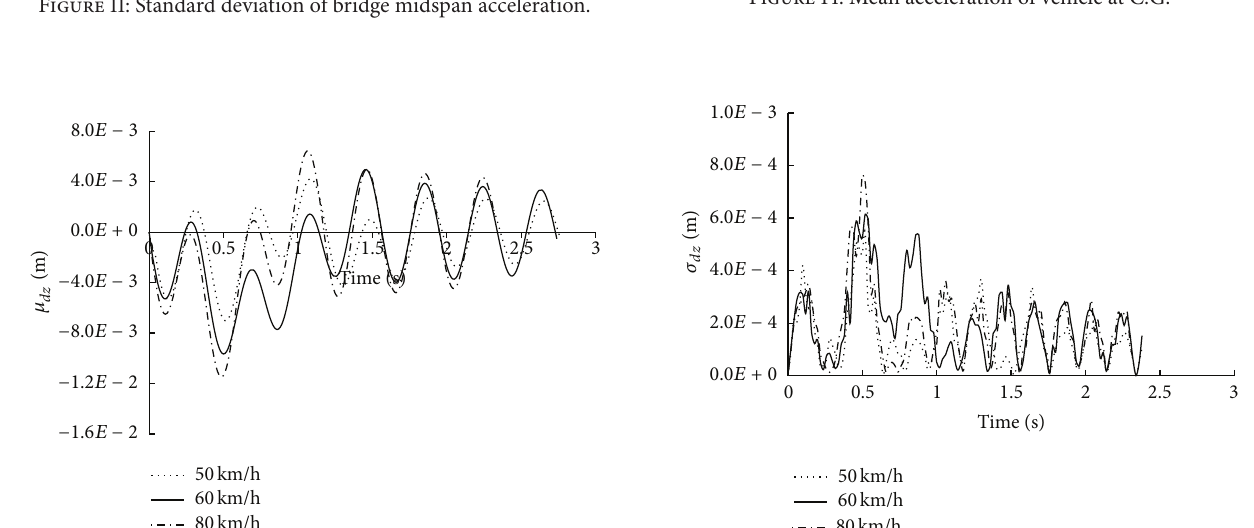
Figure 11: Standard deviation of bridge midspan acceleration.